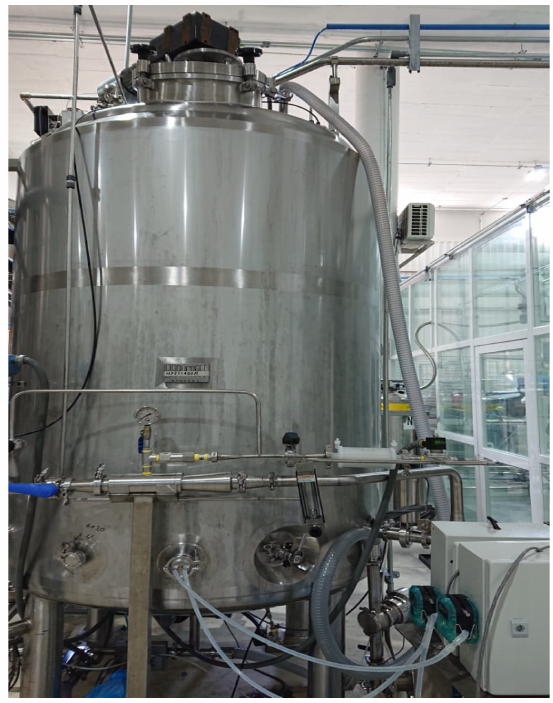
Figure 8. Mixing tank for preparation of formulations in the Punta Delicia